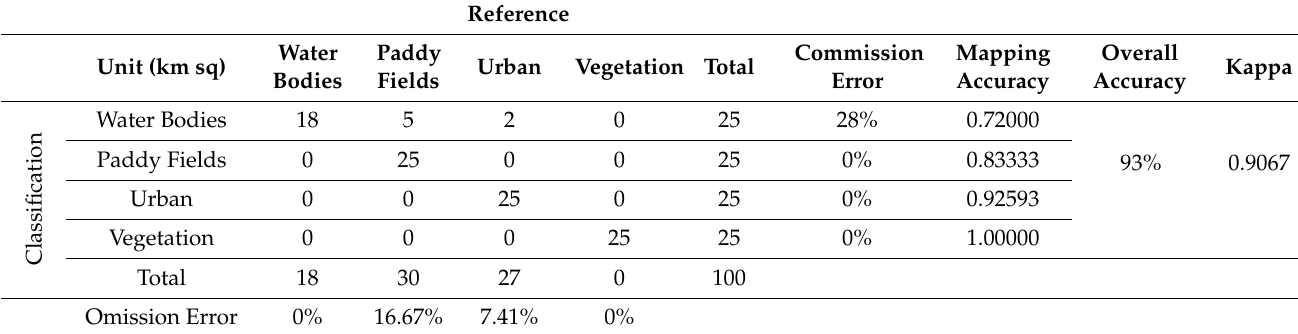
Table 5. The validation results of the land cover predictions.